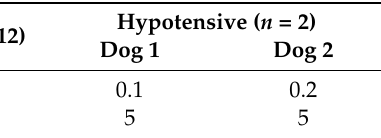
Figure 1. Representative transthoracic echocardiographic findings in dogs with myxomatous mitral valve disease (MMVD). Right parasternal long-axis view ( A ) shows thickening of the mitral leaflets (yellow arrow), enlarged left ventricle (LV), and left atrium (LA), with concurrent mitral regurgitation (MR, white arrow, grade C to D according to ACVIM). The increased left atrium diameter to aortic diameter ratio (>1.5) ( B ) as well as early velocity (E) of the mitral inflow ( C ) were observed. PA, pulmonary artery. Table 3. Catecholamine dose during protamine